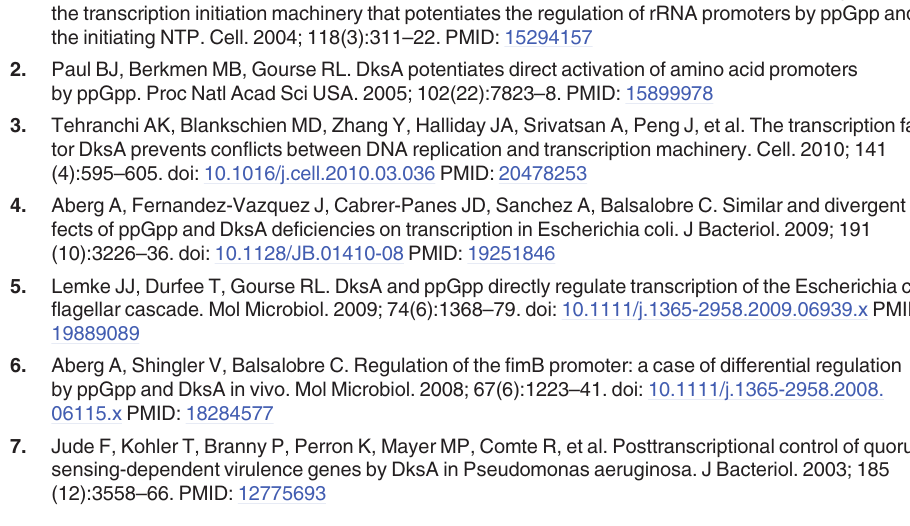
S6 Fig. Properties of DksA variants. (A) Transcription inhibition by DksA variants at the λ P promoter at different pH was measured as in S3 Fig. The IC a single exponential fit from three independent repeats. (B) Overlaid CD spectra of DksA WT and DksA H39N recorded at room temperature using 100 μ M DksA in phosphate buffer pH 8vshow no difference in their secondary structure. Similar spectra were observed for other H39 variants. (C) Comparison of thermostability of DksA WT and DksA H39 variants measured at 220 nm as described for Fig. 4. Δ Ellipticity values were used at the Y axis to better align the dif- ferent spectra and denote the change in ellipticity at increasing temperatures for each variant. Ellipticity was recorded at 220 nm wavelength. Each sample contained 50 μ M DksA in phos- phate buffer pH 8. (TIF) S7 Fig. The effect of pH on DksA N88I activity and stability. (A) The IC hibition at the rrnB P1 promoter were calculated as described for Fig. 5. (B) DksA N88I affinity to core RNAP was calculated using the localized Fe-mediated cleavage, as described for Fig. 3C. (C) Thermostability of the DksA N88I variant was determined using the differential scanning fluorimetry, as described for S4 Fig.